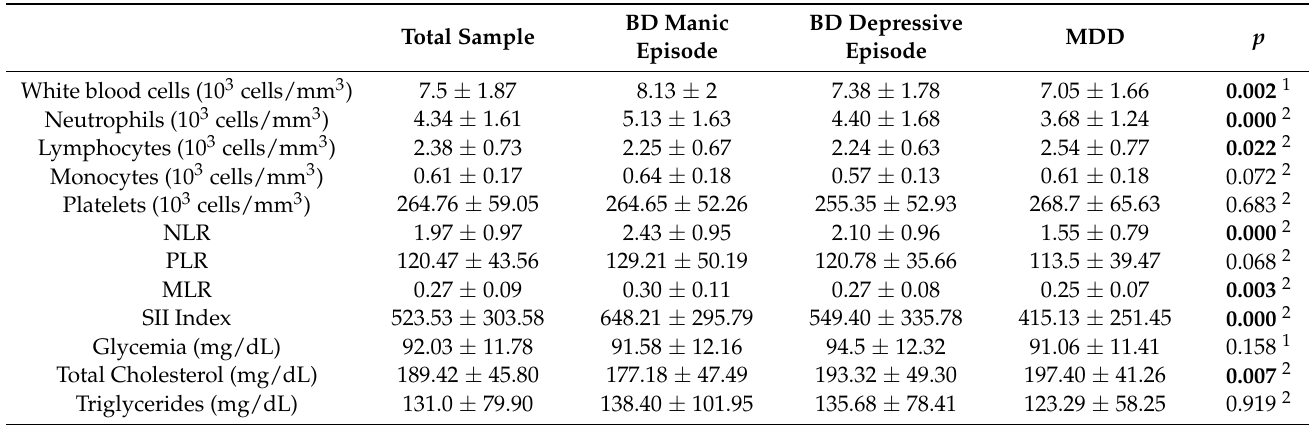
Table 2. Laboratory findings (values are presented as mean ± SD).